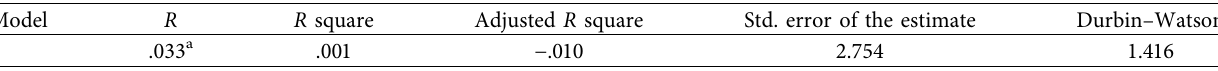
Table 8: Model summary of the relationship between the agricultural teaching approaches and food security.